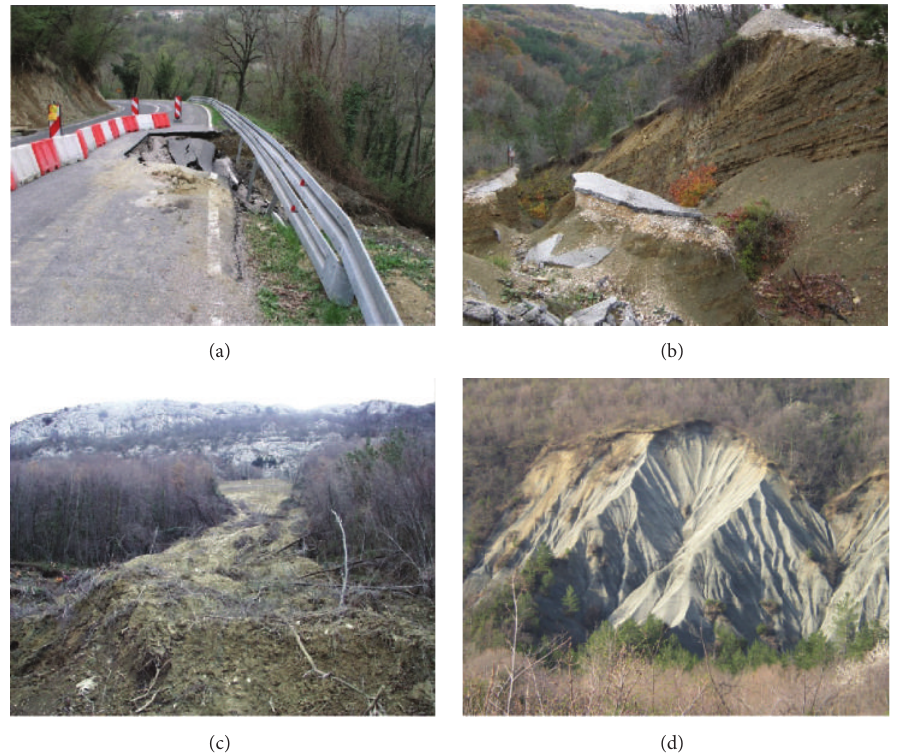
Figure 3: Geomorphological processes at the study area: (a) the rotational Marinci Landslide, (b) the translational Brus Landslide, (c) a debris flow at Krbavˇci´ci, and (d) erosion at